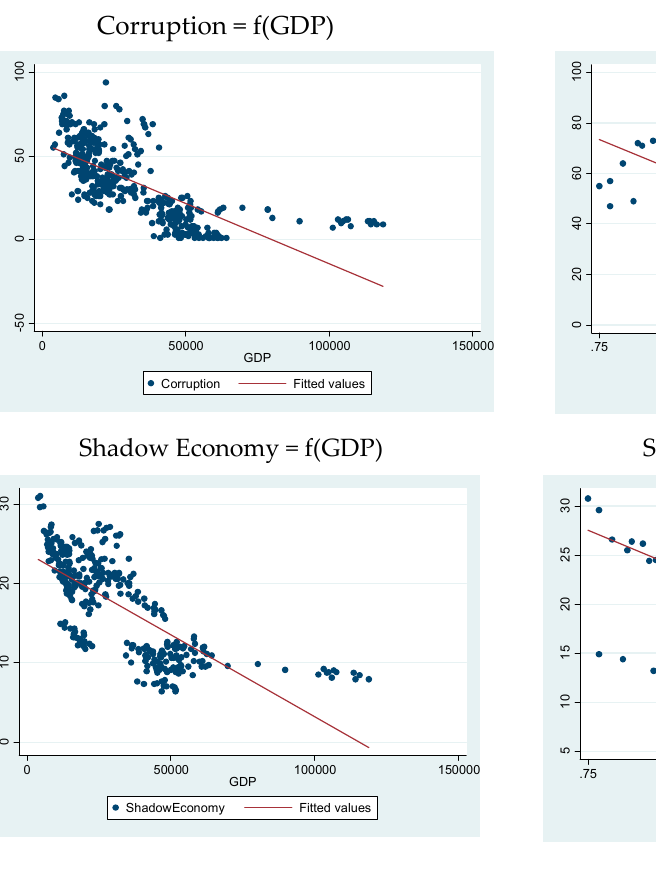
Figure 6. Human Development Index in European Union countries, 2019. Source: Authors’ processings based on Human Development Report 2019 (http://hdr.undp.org, accessed on 1 February 2021).